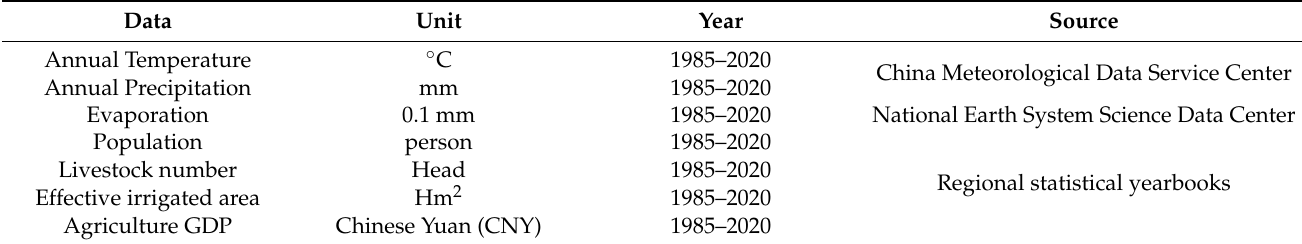
Table 1. Driving factors used in the